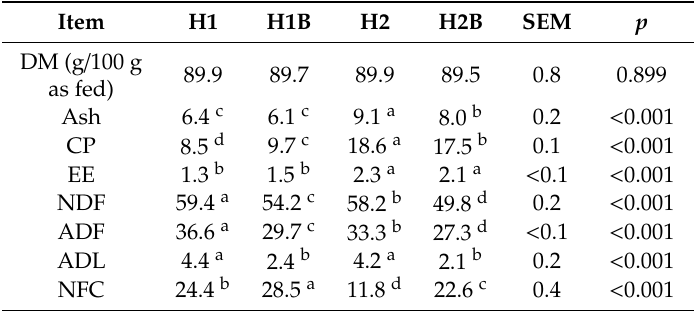
Table 1. Chemical composition of the diets (g / 100 g DM, unless otherwise stated; n = 4). Item H1 H1B H2 H2B SEM p DM (g / 100 g as